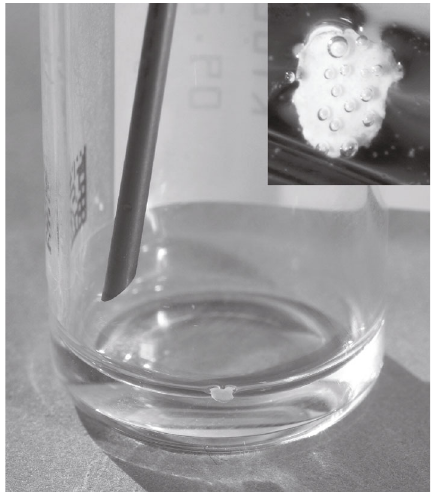
Figure 3: During the mounting process, the injector saw a larger particle of whitish colour (insert), so the process was aborted and the drug could not be used.